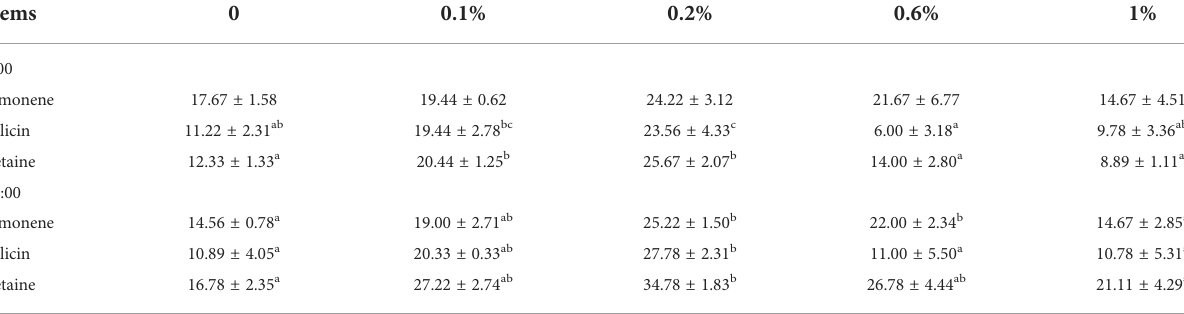
Values marked with different letters are signi fi cantly different (P < 0.05) between